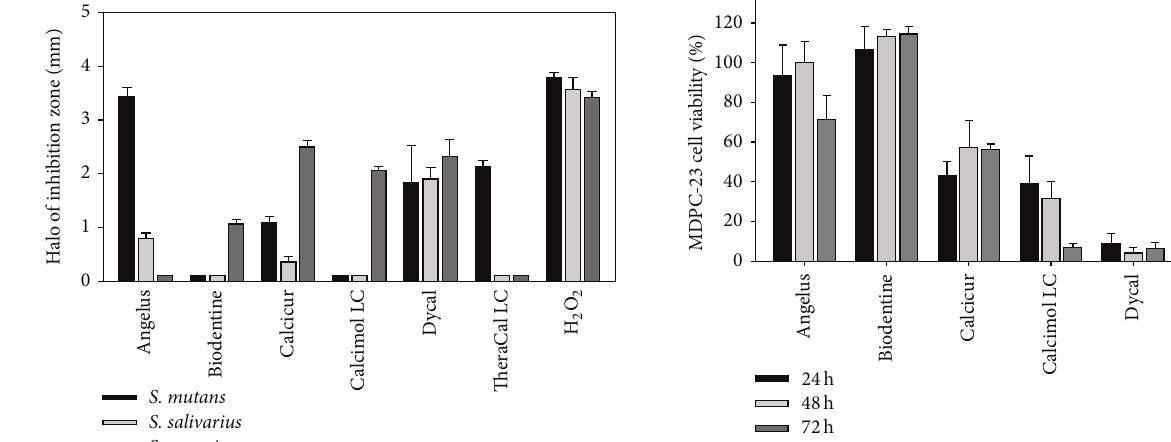
Figure 1: Antibacterial activity of the different pulp-capping mate- rials evaluated by agar diffusion test. Each paper disk impregnated with the different pulp-capping materials was placed on agar plates previously incubated with the indicated streptococcal strains and incubated at 37 ∘ C for 24 h. The positive control was represented by a 10%dilutionof30%H 2 O 2 .Alltheassayswereconductedintriplicate and the results were recorded in terms of the average diameter of inhibition zone (mm). Error bars indicate standard errors of the means.